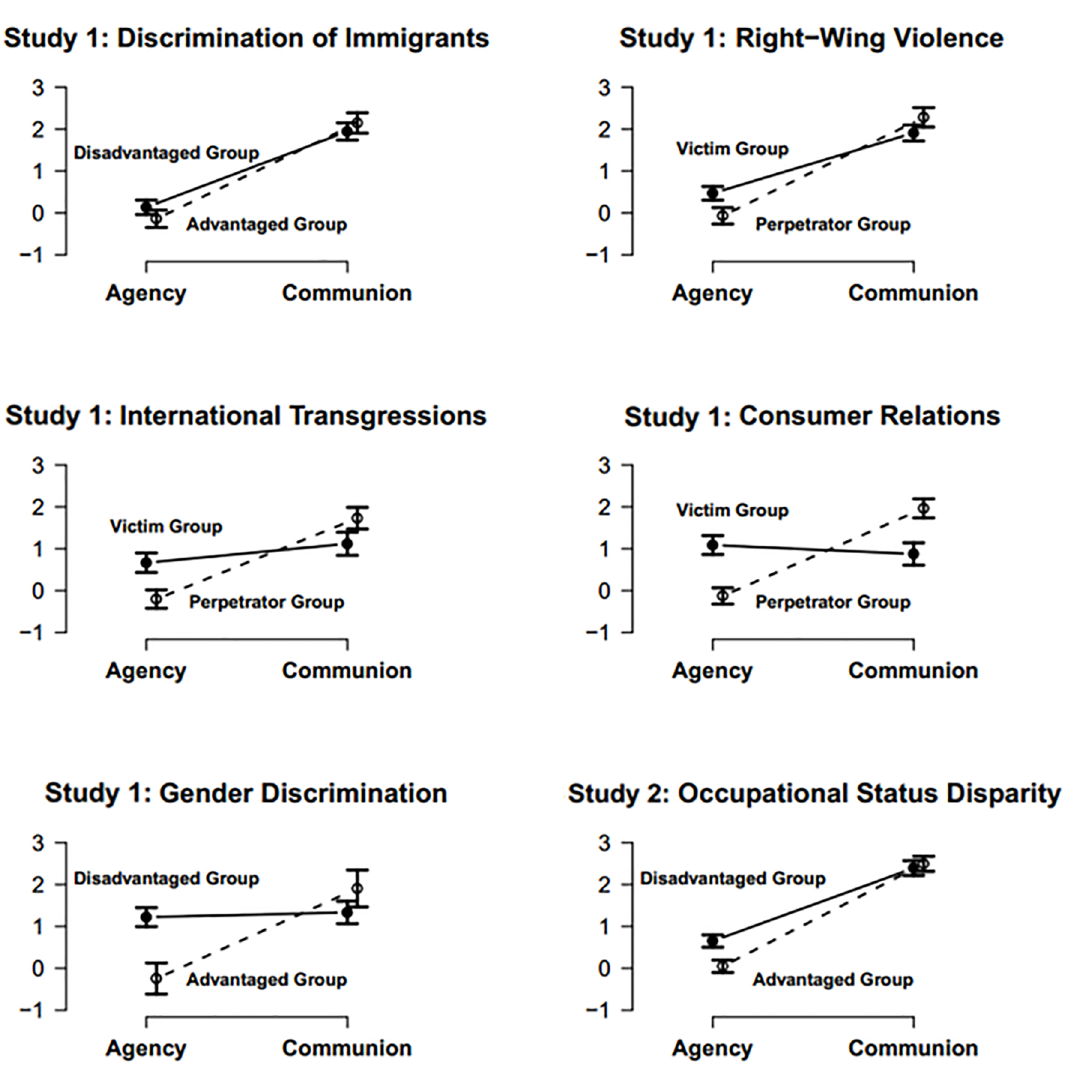
Figure 1. Means and 95% confidence intervals of agency and communion vector scores in the different contexts of Study 1 and